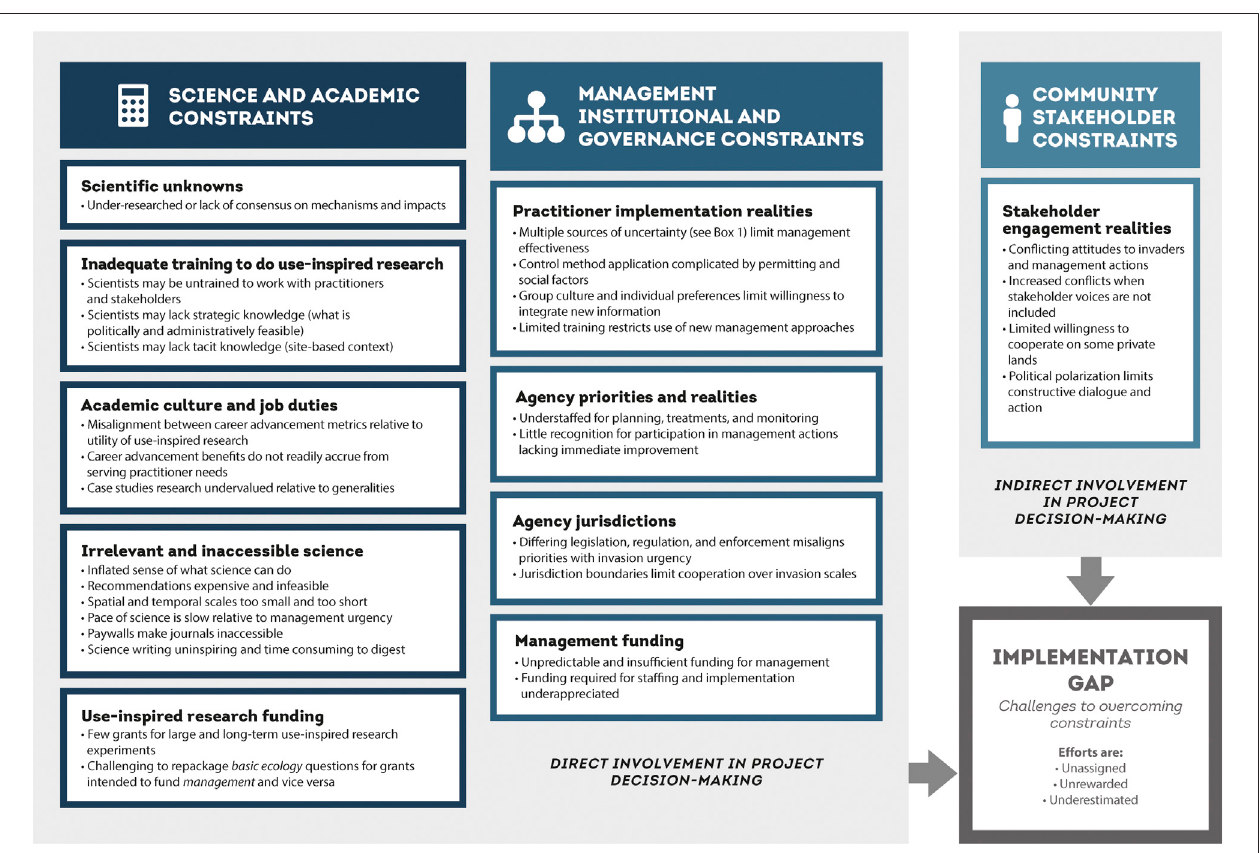
FIGURE 1 | Constraints to the management of wetland plant invasions are broad and span ecological and social realms. Science constraints result from the challenges of doing management-relevant science in academic and research institutions. Management constraints arise from institutional, governance, and fi